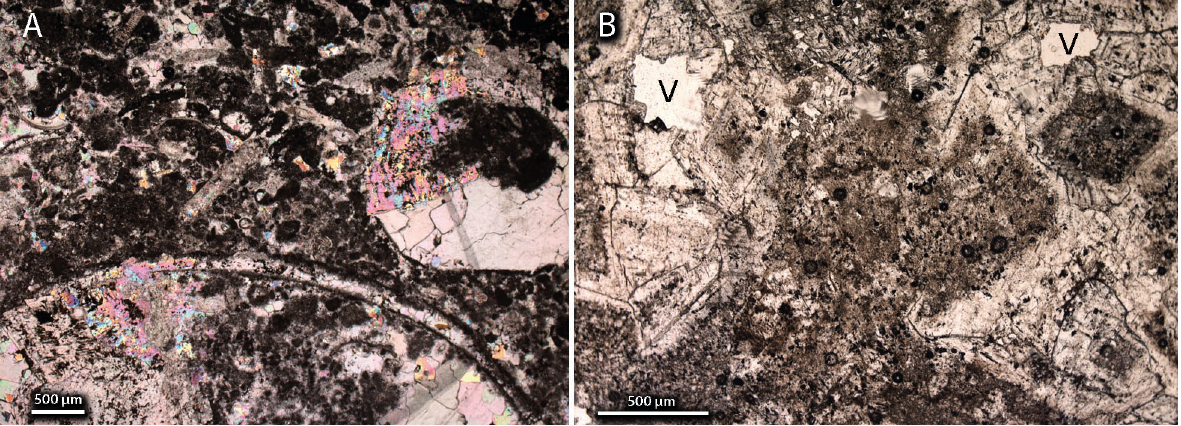
Fig. 4. Thin section photomicrographs of ( A ) Plavinas limestone and ( B ) limestone precipitated during dedolomitization. The limestone is rich in fossil remains, while in matrix of unfossiliferous vuggy (V in part B) dedolomite some remnant dolomite zoned rhombs are preserved. A, Hino drill core, 49.4 m, GIT 441-640; B, Marinova quarry 4, GIT